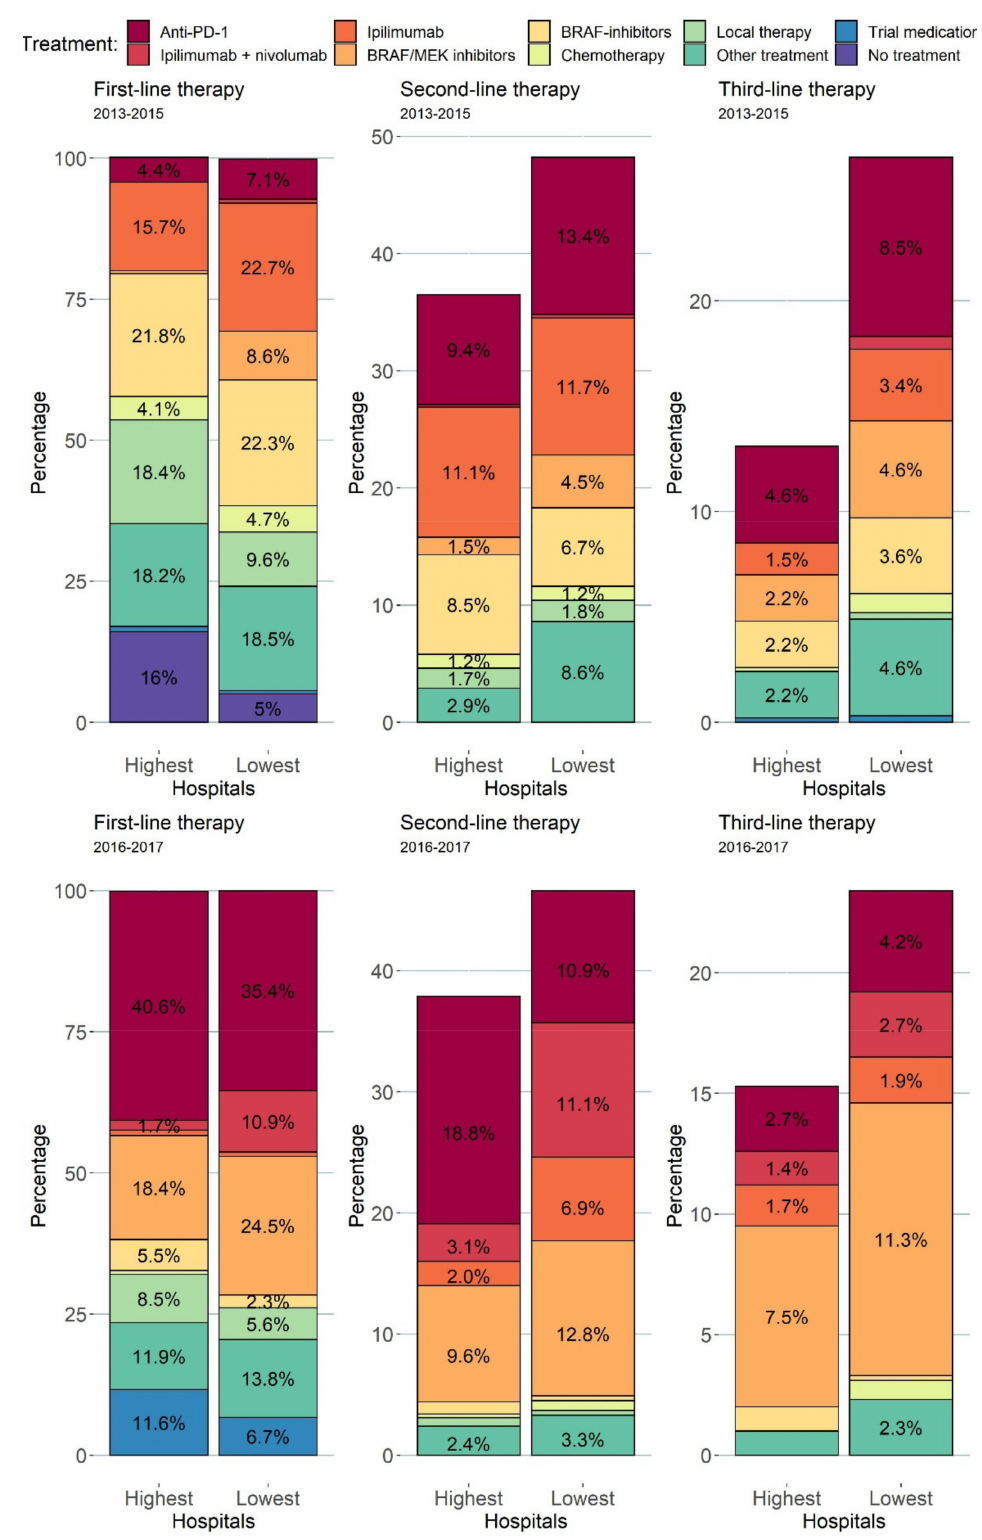
Figure 4. Stacked bar plots showing the treatments in the first, second, and third line of treatment. The three hospitals with the highest HRs ( N = 413) and lowest 2-year survival are compared to the three hospitals with the lowest HRs ( N = 674) according to the model. The top row shows patients diagnosed between 2013 and 2015, and the bottom row shows patients diagnosed between 2016 and 2017. Treatments administered after 3 December 2020 and labels of percentages < 1% are not shown in this